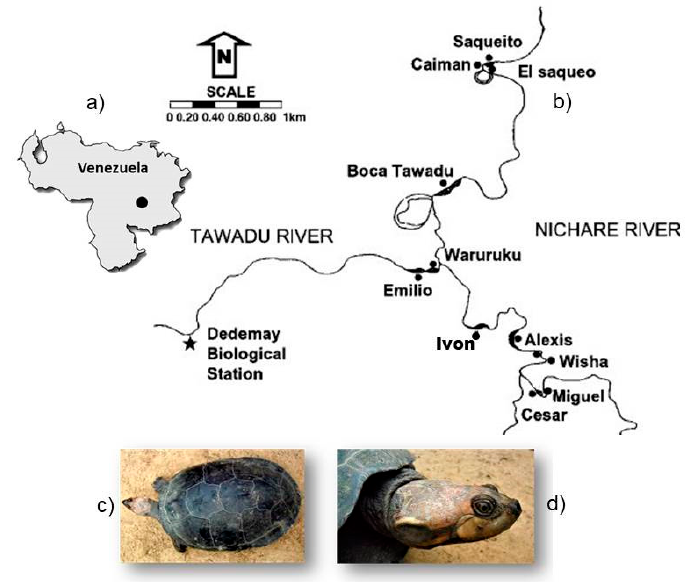
Figure 1. Map of Venezuela (study area in black dot, subpanel a ) and map of the study area showing the 11 beaches that were monitored during nesting season 1999, 2000 and 2001 (El Saqueo = 6°23 ′ 39“ N, 64°57 ′ 31 ′′ W; Caiman = 6°23 ′ 38 ′′ N, 64°57 ′ 36 ′′ W; Saqueito = 6°23 ′ 42“ N, 64°57 ′ 19 ′′ W; Boca Tawadu = 6°22 ′ 01 ′′ N, 64°58 ′ 16 ′′ W; Waruruku = 6°21 ′ 02 ′′ N, 64°58 ′ 18 ′′ W; Emilio = 6°20 ′ 59 ′′ N, 64°58 ′ 29 ′′ W; Ivon = 6°20 ′ 12 ′′ N, 64°57 ′ 51 ′′ W; Alexis = 6°20 ′ 07 ′′ N, 64°57 ′ 27 ′′ W; Wisha = 6°19 ′ 47 ′′ N, 64°57 ′ 13 ′′ W; Cesar = 6°19 ′ 19 ′′ N, 64°57 ′ 14 ′′ W; Miguel = 6°19 ′ 24 ′′ N, 64°57 ′ 17 ′′ W) (subpanel b ). Additional beaches existed within the study area that were used negligibly or not at all by Podocnemis unifilis females during the study period. Mature adult female of P. unifilis (dorsal—subpanel c ; head view—subpanel d ; photographs by Andrés Felipe Aponte). Mean size (linear length of carapace) of mature adult females in the study area was 37.4 ± 2.92 cm ( n = 901).